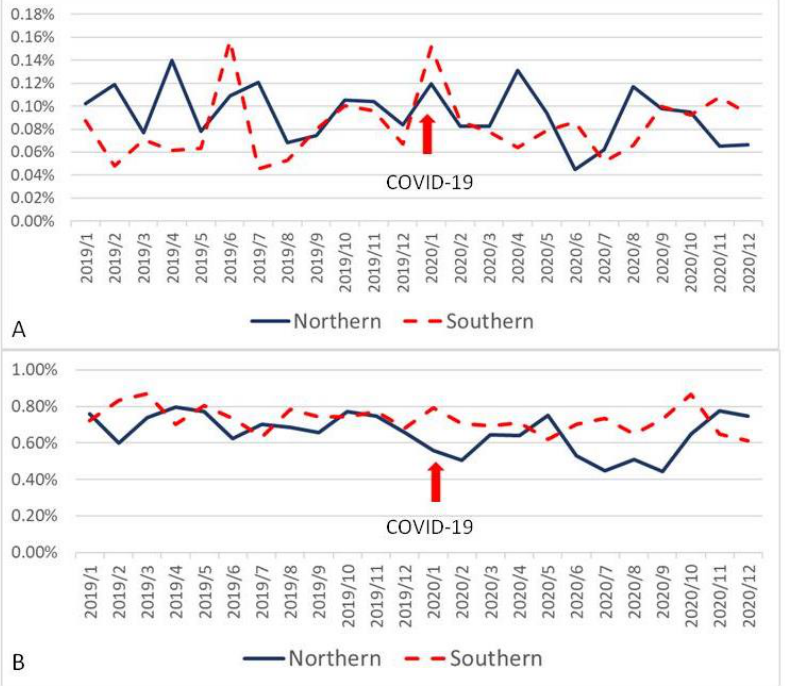
Figure 3. Control chart of surgery-related quality indicators based on the location of medical centers (red arrow represents outbreak of COVID-19). ( A ): Mortality within 48 h for surgical patients excluding critical discharge against medical advice. ( B ): Unscheduled returns to the OR for the surgical patients during hospitalization.